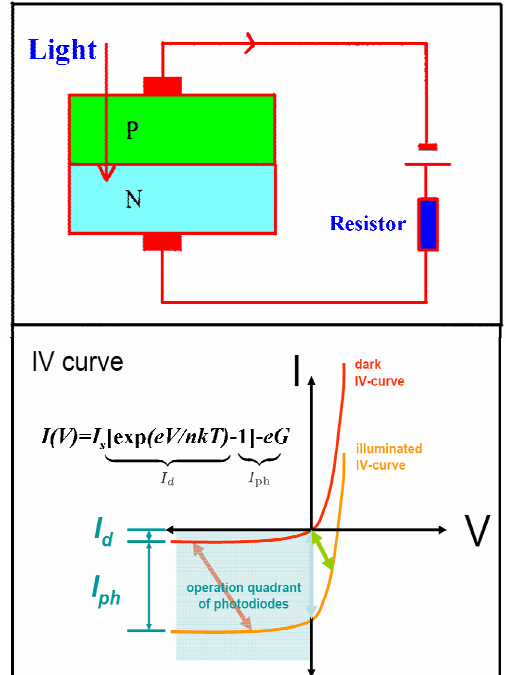
Figure 9. The schematic structure and I-V characteristic of p-n